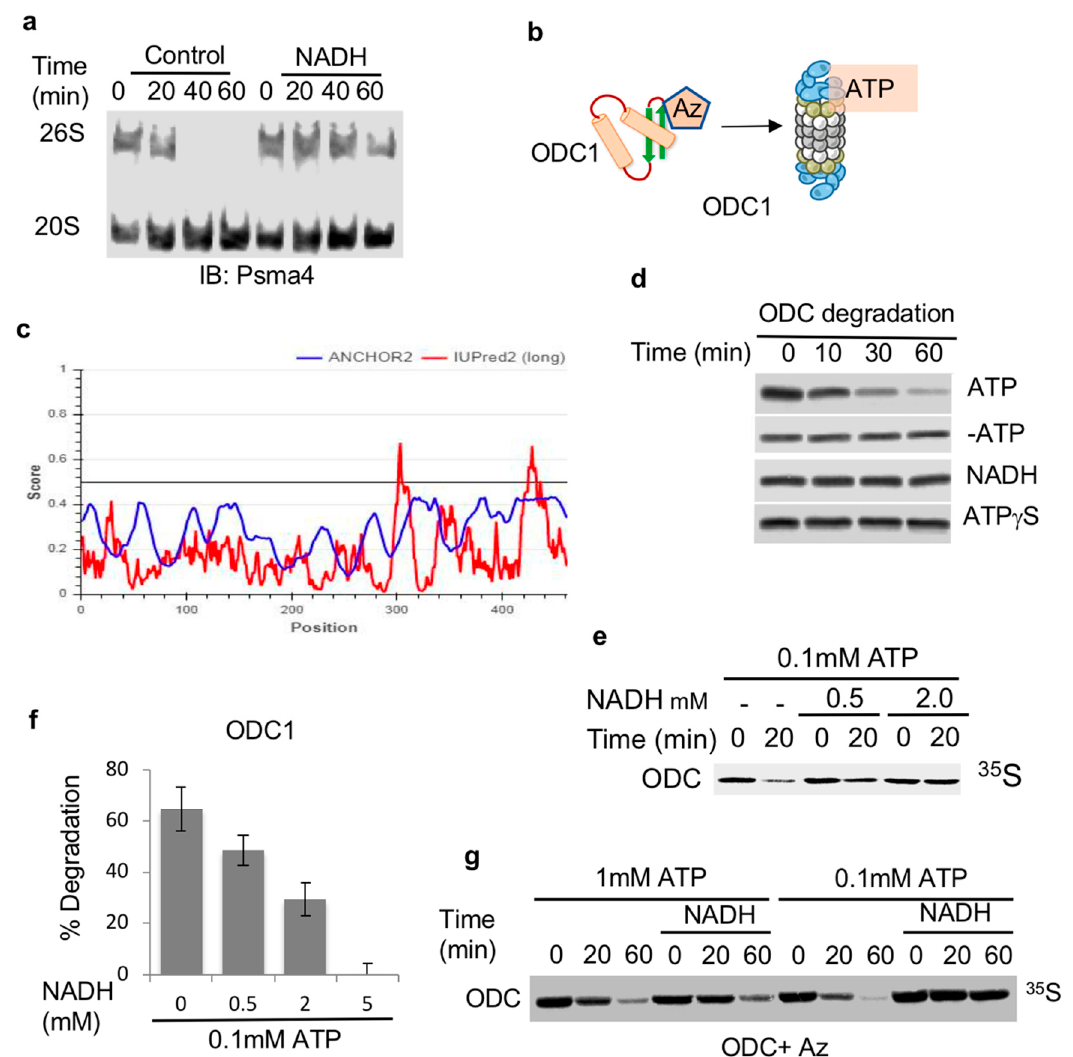
Figure 1. ODC is degraded by ATP-26S but not by NADH-26S proteasome. ( a ) NADH stabilizes the 26S PC. Proteasomes fractionated from NIH3T3 cells were incubated at 37 ◦ C for indicated times in the presence or absence of 2 mM NADH. ( b ) Scheme / model ( c ) ODC (UniProt P11926) is, by large, an ordered protein based on the scores of prediction output using IUPred2A (the red curve) and ANCHOR2 (the blue curve) prediction programs. ( d ) NADH-26S proteasomes cannot induce ODC degradation by Az. ODC degradation in rabbit reticulocyte extract by Az was examined in the presence or absence of 2 mM ATP and an ATP-regenerating system (ATP). This reaction was also conducted under removal of the ATP by Apyrase (-ATP). Similar reactions were conducted in the presence of 2 mM NADH with Apyrase (NADH) and 2 mM ATP γ S with Apyrase (ATP γ S). ( e ) NADH represses ODC degradation. In vitro translated 35 S Methionine-labeled ODC was subjected to degradation in reticulocyte lysate in the presence of Antizyme (Az). ODC degradation was examined in the presence of 0.1 mM ATP and increasing concentrations of NADH at 37 ◦ C for 20 min. ( f ) The data from at least three independent experiments were averaged and shown with their standard deviation. ( g ) The NADH-mediated inhibition of ODC degradation is alleviated by higher ATP concentration. ODC degradation was examined in the presence of 1 mM or 0.1 mM ATP in the presence or absence of 5 mM NADH for the indicated time points at 37 ◦ C. The level of 35 S-labeled ODC degradation was visualized by autoradiography following SDS-PAGE and quantified.